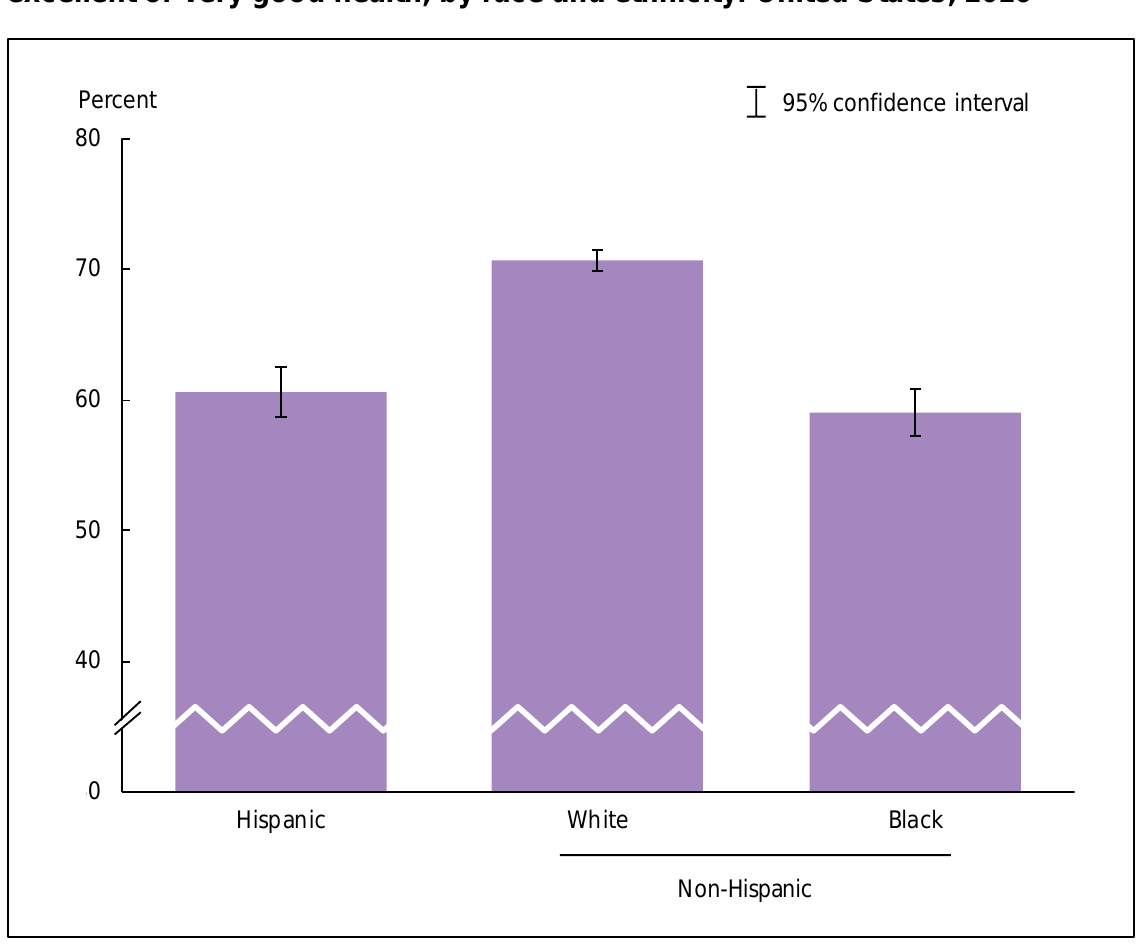
Figure 11.4. Age-sex-adjusted percentage of persons of all ages who had excellent or very good health, by race and ethnicity: United States,